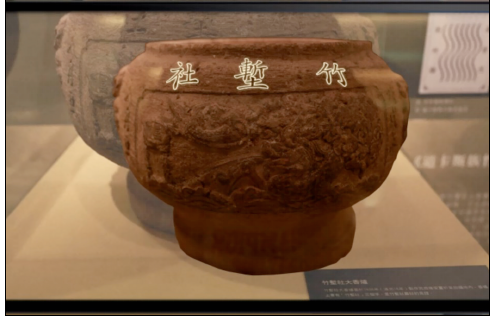
Figure 10. Scanning corroded item to show its original appearance, which is recovered from the historical